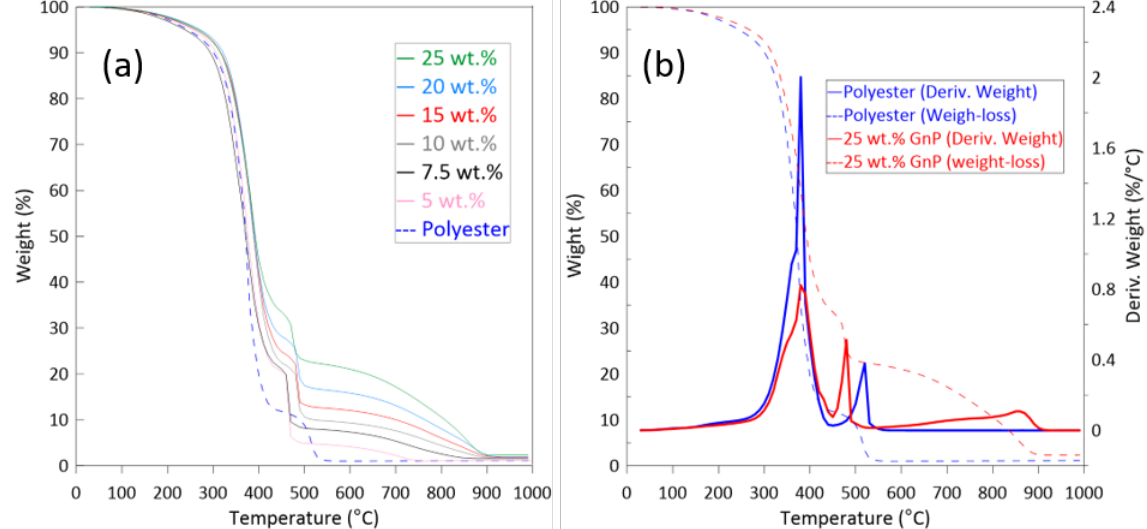
Figure 5. Weight over temperature ( a ) and derivative of weight over temperature ( b ) for neat polyester and polyester filled with Gr3X.